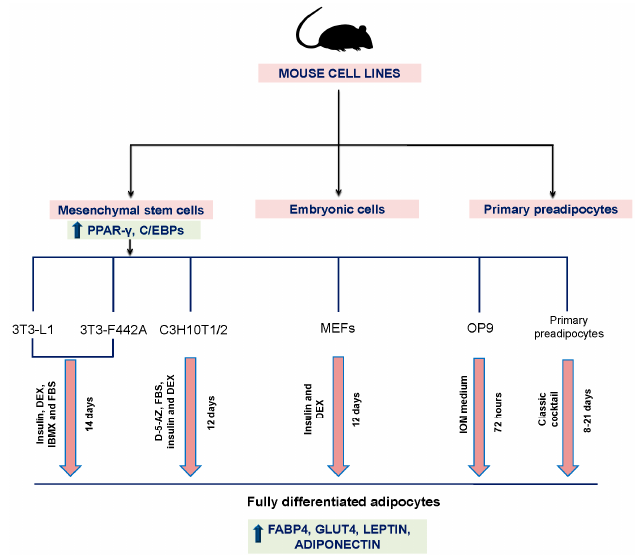
Figure 1. Mouse cell lines to study the adipogenesis process. DEX, dexamethasone; FBS, fetalbovineserum; IBMX, 3-isobutyl-1-methylxanthine; D-5-AZ, demethylating agent 5-azacytidine;